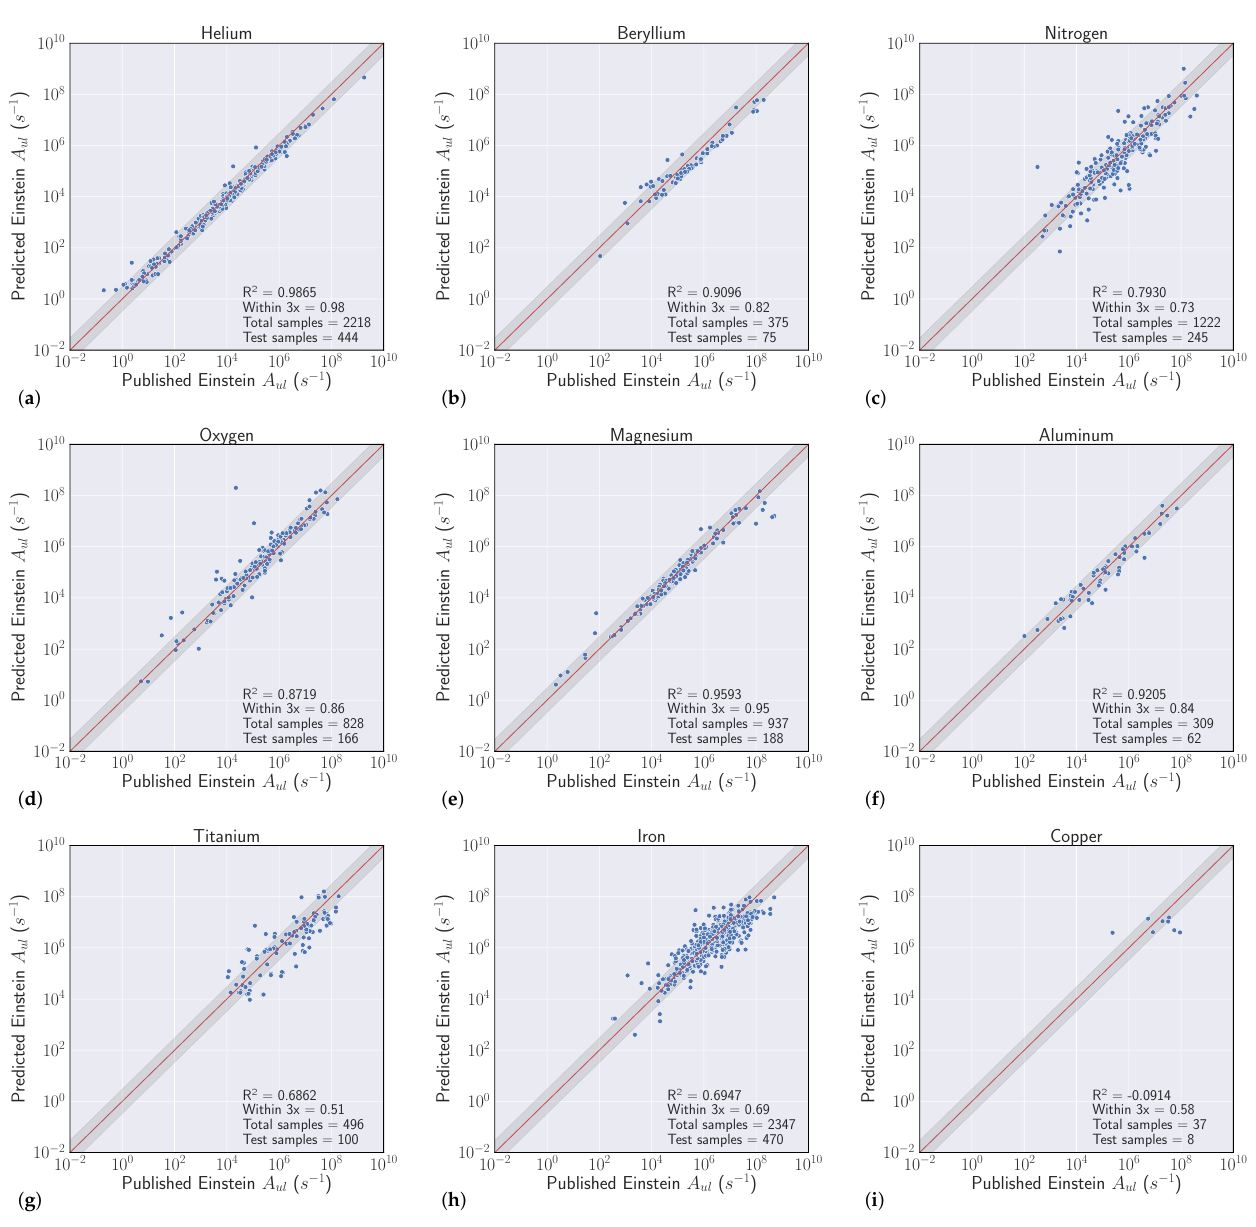
Figure 4. Predicted vs. published Einstein A-coefficients for intraelement